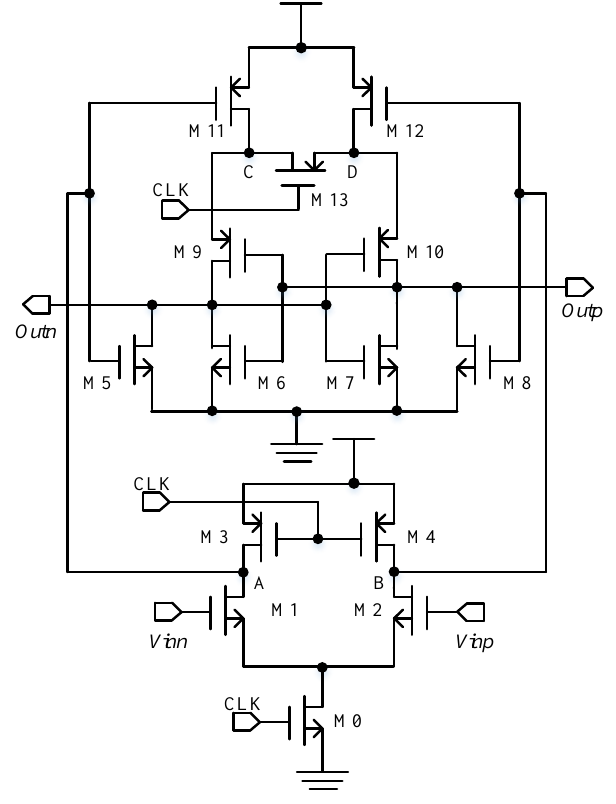
Figure 6. Latch comparator